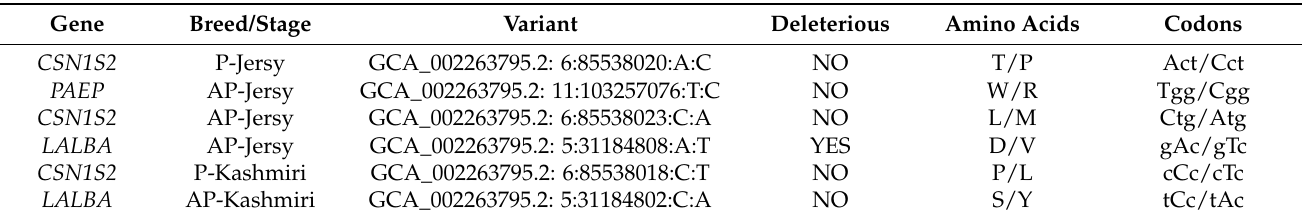
Table 6. Novel missense variants in major milk protein genes.